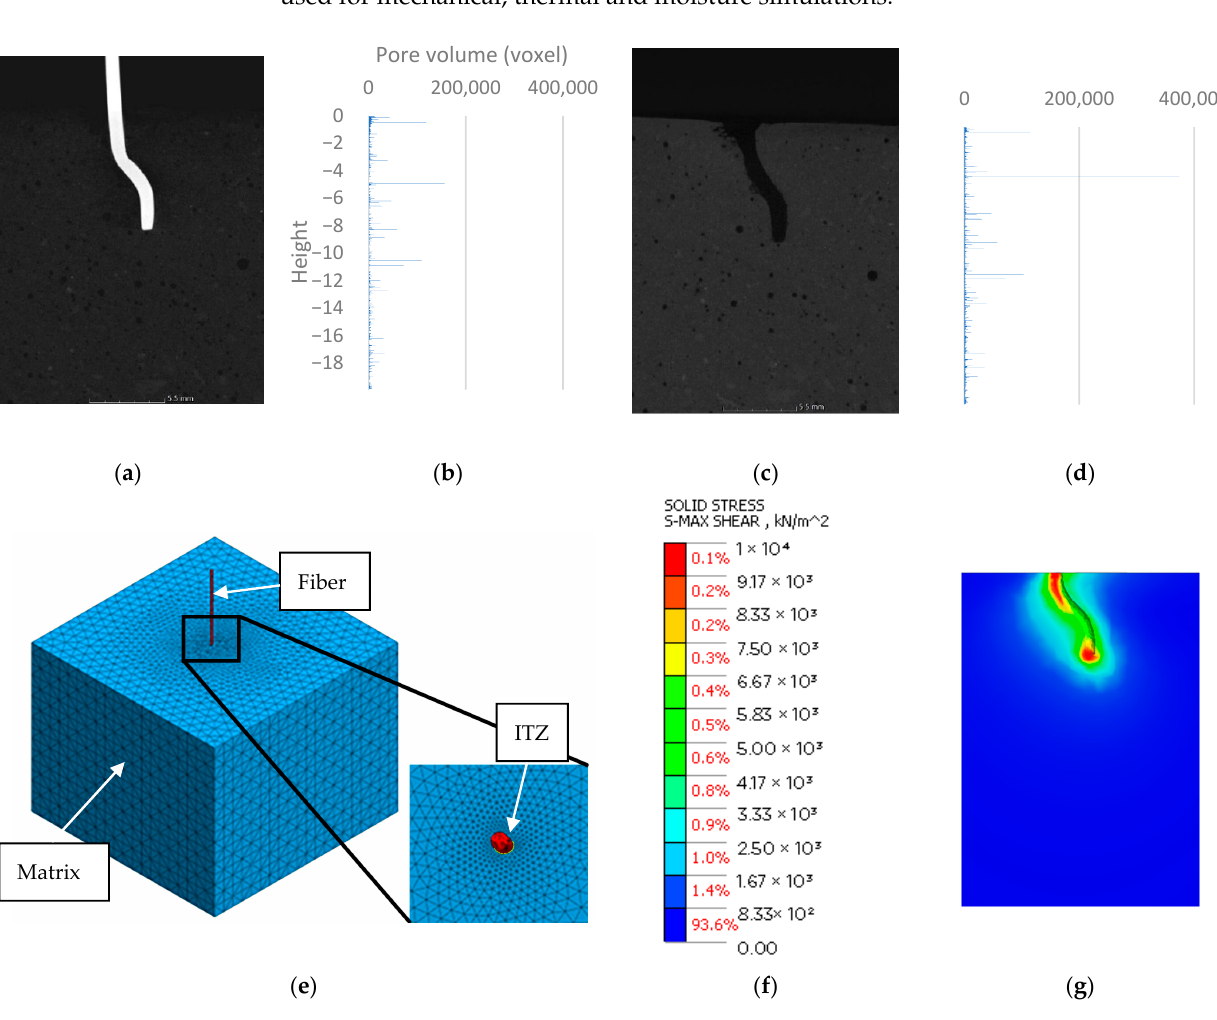
Figure 7. 10 mm sample: ( a ) 2D cross-section before fiber pullout; ( b ) 3D porosity analysis—plot of pore volume against height in specimen before fiber pullout; ( c ) 2D cross-section after fiber pullout; ( d ) 3D porosity analysis—plot of pore volume against height in specimen after fiber pullout; ( e ) meso-scale model; ( f ) stress scale; ( g ) FEM results—materials with permission of the authors [126].